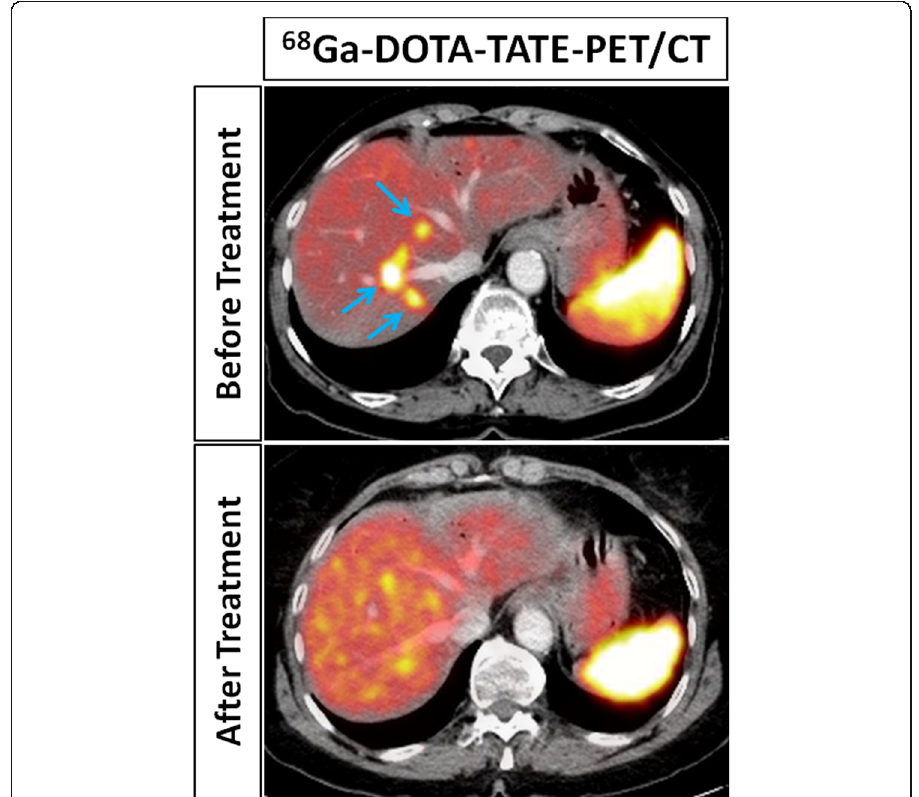
Fig. 6 68 Ga-DOTA-TATE-PET/CTs in a patient with metastatic neuroendocrine tumor before (top row) and after (bottom row) radionuclide therapy with 177 Lu-DOTA-TATE. The pre-treatment diagnostic scan showed multiple avid liver metastases (arrows), implying that they would also bind the 177 Lu-labelled therapeutic ‘ sister agent ’ , therefore predicting the treatment response that was ultimately demonstrated on the post-therapeutic PET/CT. Physiologic splenic tracer uptake is seen on both